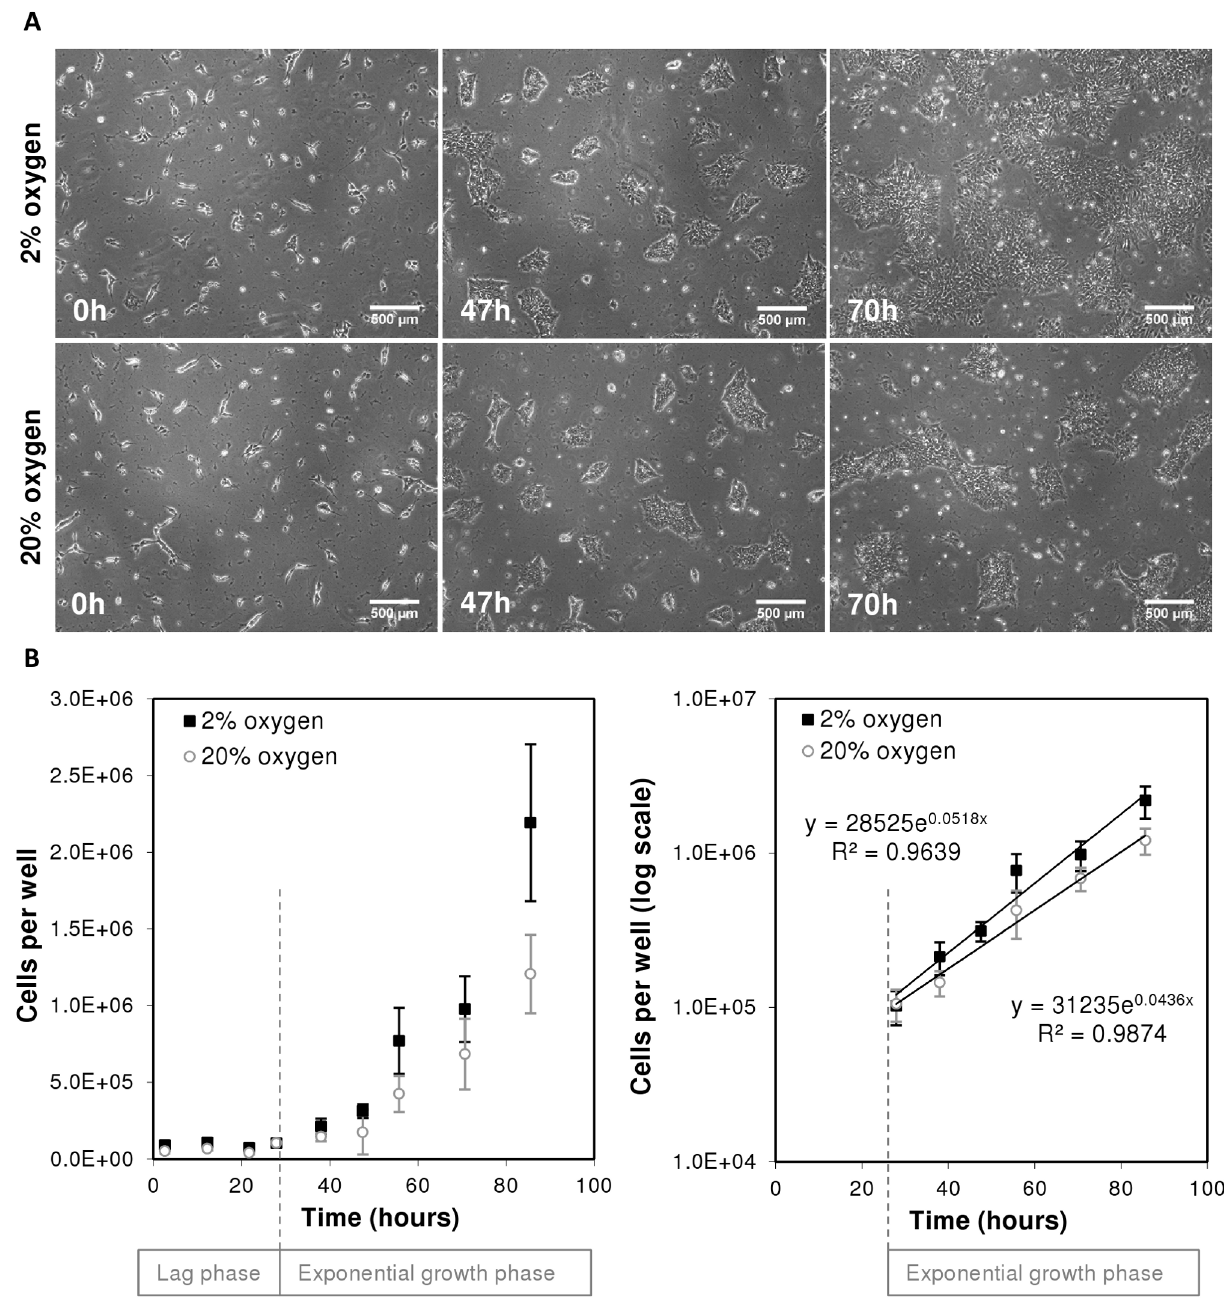
Figure 2. Growth profile of human embryonic stem cells cultured at physiological and atmospheric oxygen concentrations. hESCs were harvested as a single cell suspension and then FACS sorted into 6-well plates to ensure a uniform seeding distribution across all wells. The cells were then cultured at physiological, 2%, and atmospheric, 20%, oxygen concentrations. At each time point cells were harvested and counted using flow cytometry techniques. A) The phase contrast images represent the spatial distribution of cells in the well and colony morphology at time equals 0, 47 and 70 hours after the experiment initialisation. The cell seeding methodologies employed allowed for consistent uniform seeding which translated to consistent initial cell numbers. Scale bar represents 500 m m. B) Growth profile of hESCs showing the lag and exponential growth phase on the semi-log plot to determine the specific growth rates. Values are means 6 standard deviation, n=6.